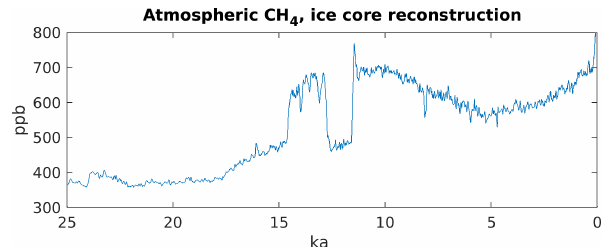
Figure 1. Atmospheric CH 4 as reconstructed from ice cores (Köh- ler et al., 2017, and references